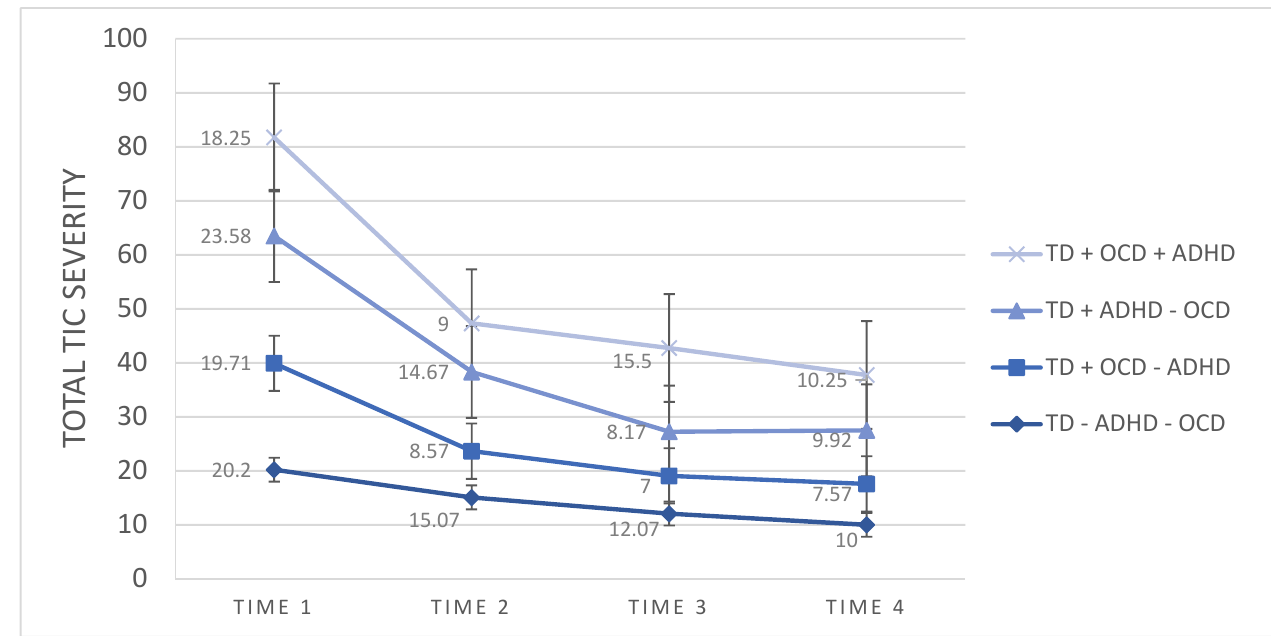
Figure 1. Mean of baseline (time 1), post-intervention (time 2), 3-month (time 3) and 6-month (time 4) scores on Yale Global Tic Severity Scale Total Tic Score measure of TD + OCD + ADHD, TD + ADHD − OCD, TD + OCD − ADHD, TD − ADHD − OCD.